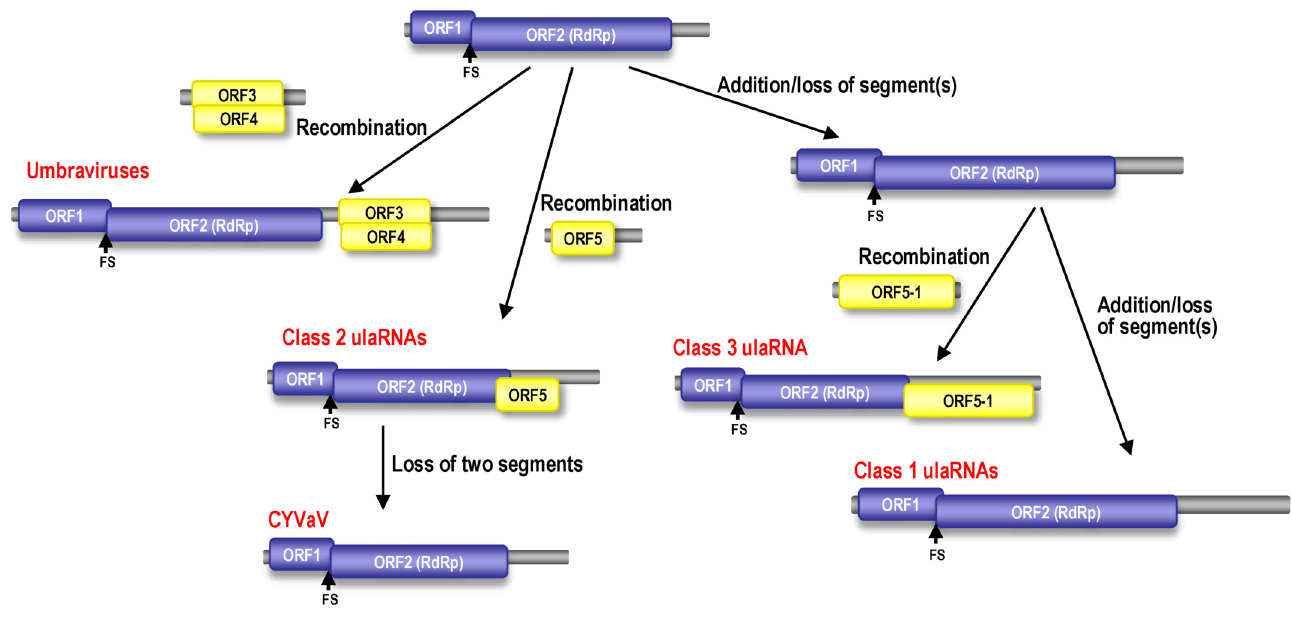
Figure 14. Model for the evolution of ulaRNAs and umbraviruses. See text for explanation. FS, -1PRF